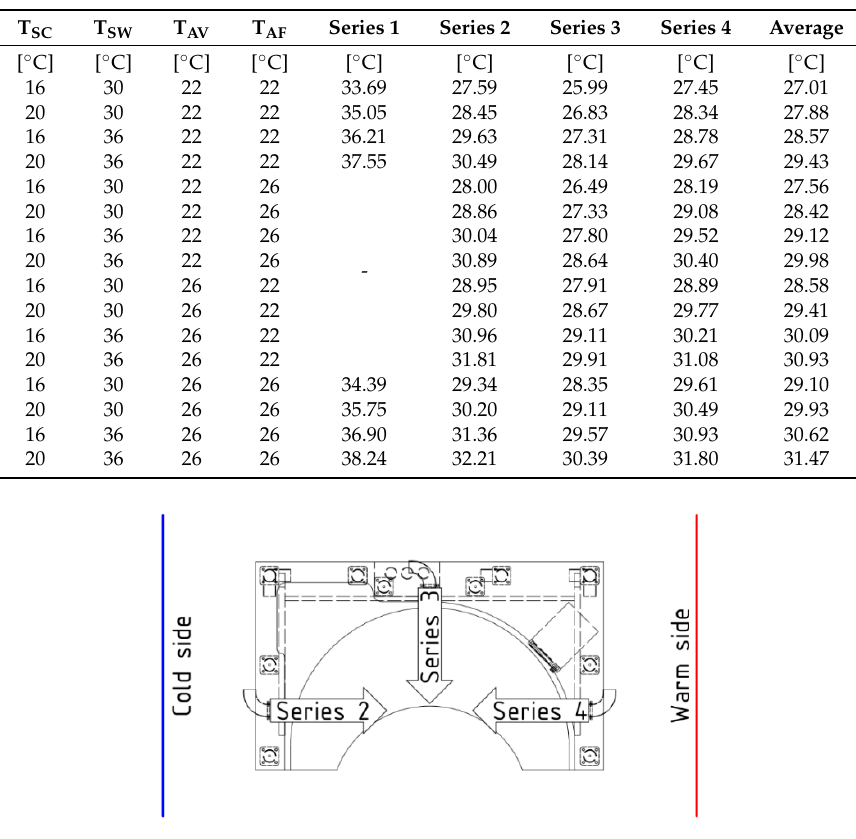
Figure 9. Sketch of the measurement setup.